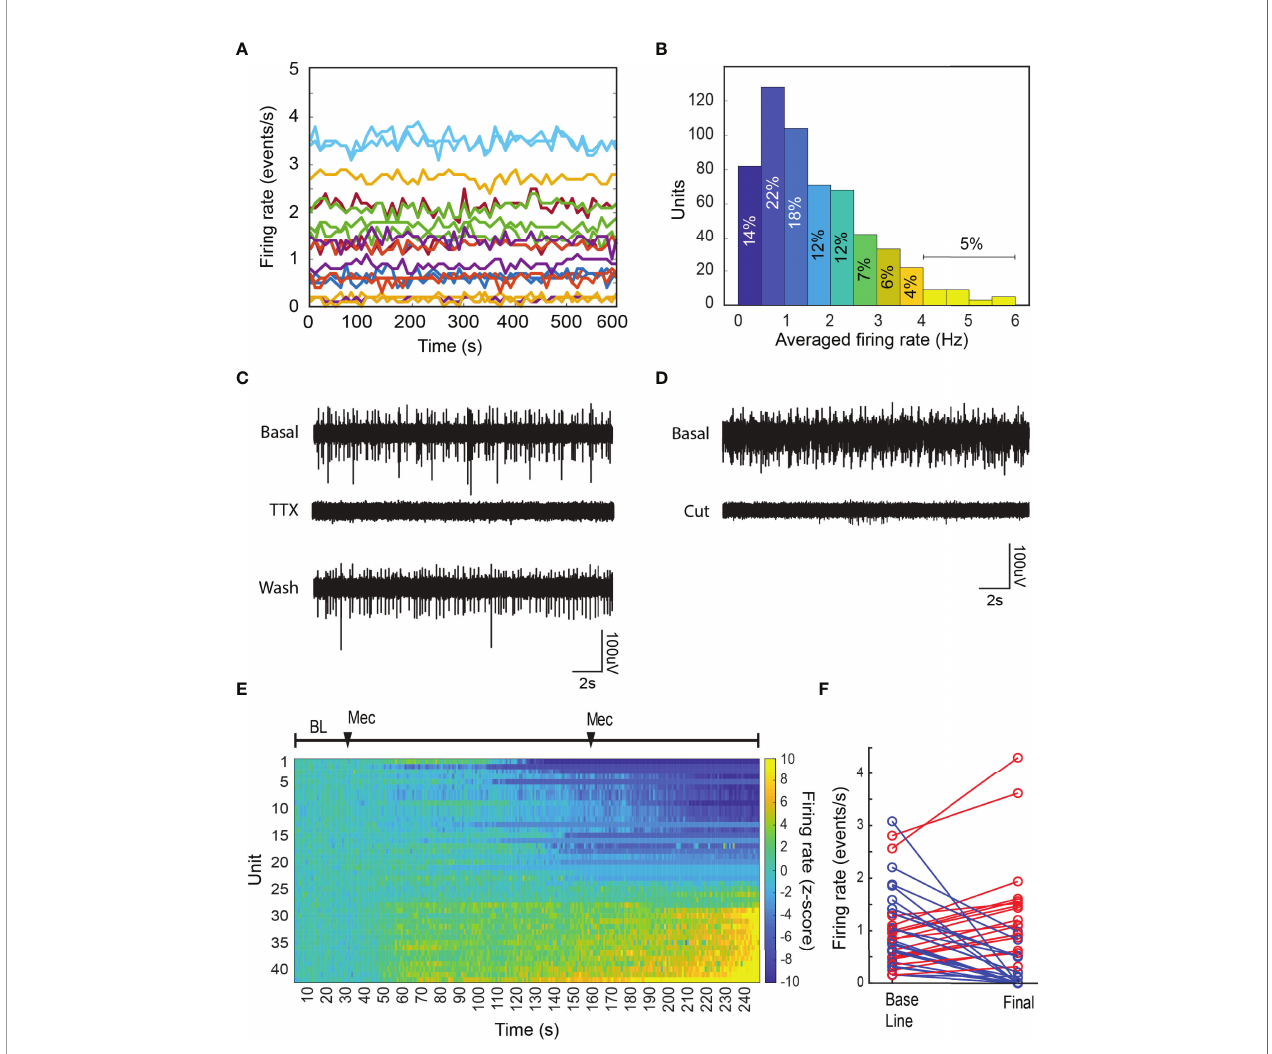
FIGURE 2 | Basal chromaf fi n cell activity is driven by the splanchnic nerve. (A) Firing rate in 10 s bins from a set of units recorded for 10 minutes under basal conditions in a single preparation. (B) Averaged fi ring rate distribution from 576 units recorded during 40 preparations. (C) The local application of the sodium channel blocker TTX, reversibly blocks the activity in the adrenal medulla. The effect was seen in all recording sites. (D) Severing the splanchnic nerve proximally to the adrenal gland, irreversibly abolishes the electrical activity in the adrenal medulla. Basal activity was monitored for ten minutes prior to the cut, and the shown cut recording was done within a minute. (E) The systemic application of the nicotinic antagonist mecamylamine hydrochloride inhibits a subset of the chromaf fi n cells population in the adrenal medulla. The fi ring rate was estimated in 10 s bins and the normalized fi ring rate (z-score, see Methods) was calculated by considering the fi rst 5 minutes of the recording as baseline. After the baseline period two 2 mg intraperitoneal doses of mecamylamine were administered at 5 and 25 minutes. (F) Shows the averaged fi ring rate from each unit during the baseline period vs. the fi nal 5 minutes of the recording (blue=inhibited,